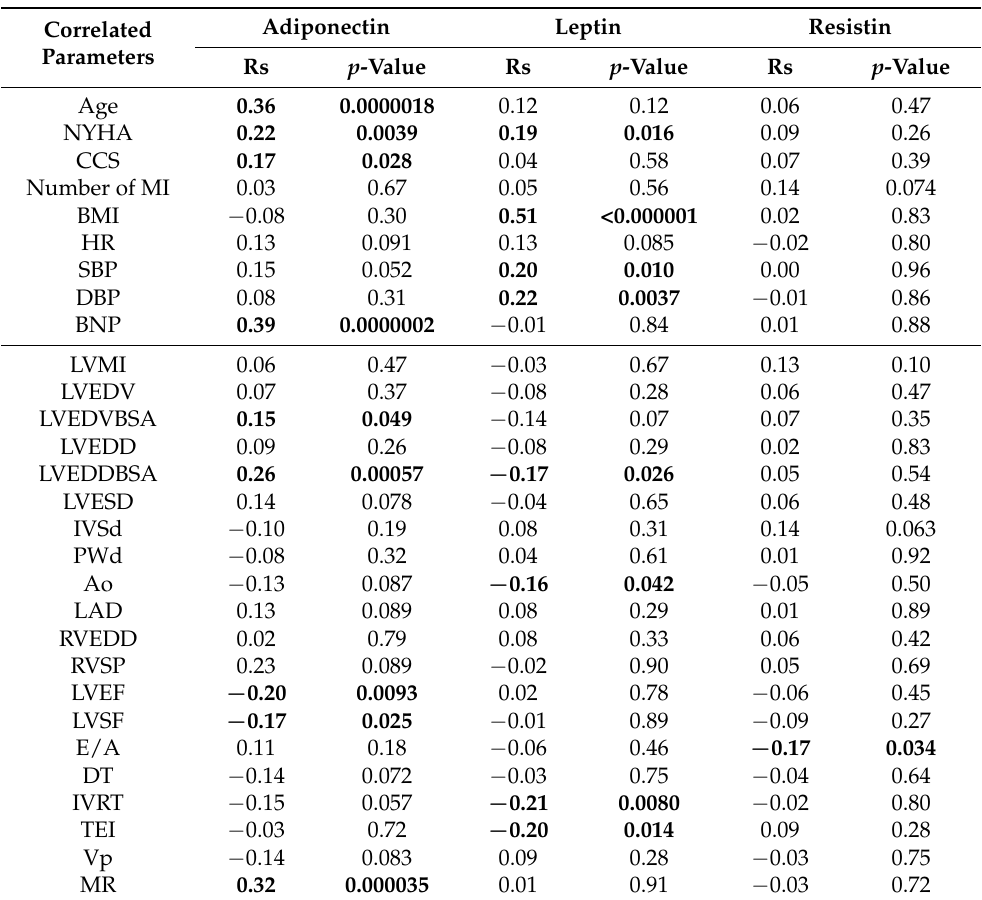
Table 2. Correlations of plasma adipokine concentrations with clinical and echocardiographic parameters in patients with CAD (Spearman rank correlation coefficients). Correlated